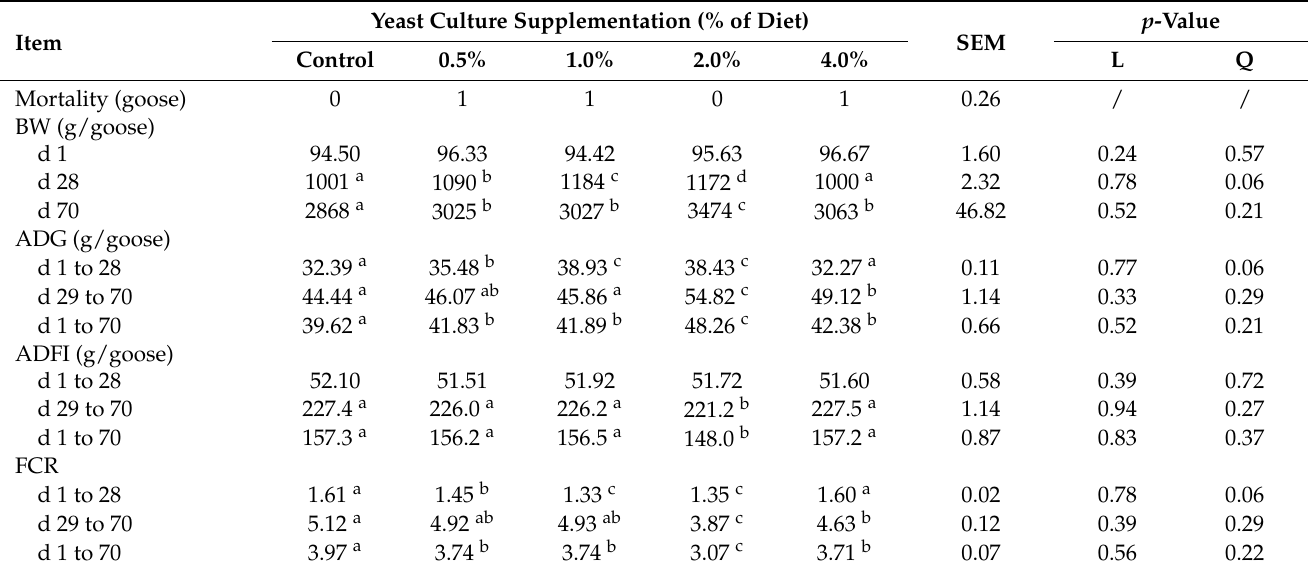
Table 3. Effect of supplemental yeast cultures in geese diets on growth